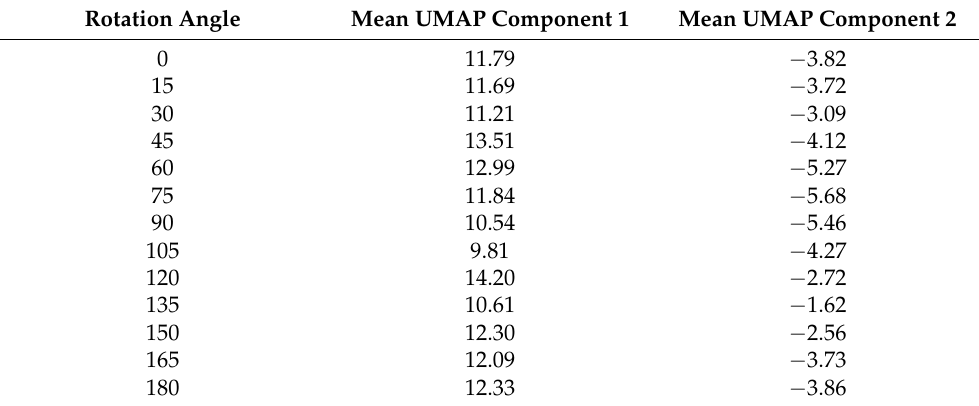
Table 2. Mean 2D UMAP coordinates for the C-band circular crop images from the 2D latent space representation, as shown in Figure 9. For each augmentation set, the rotation angle and coordinates are listed.